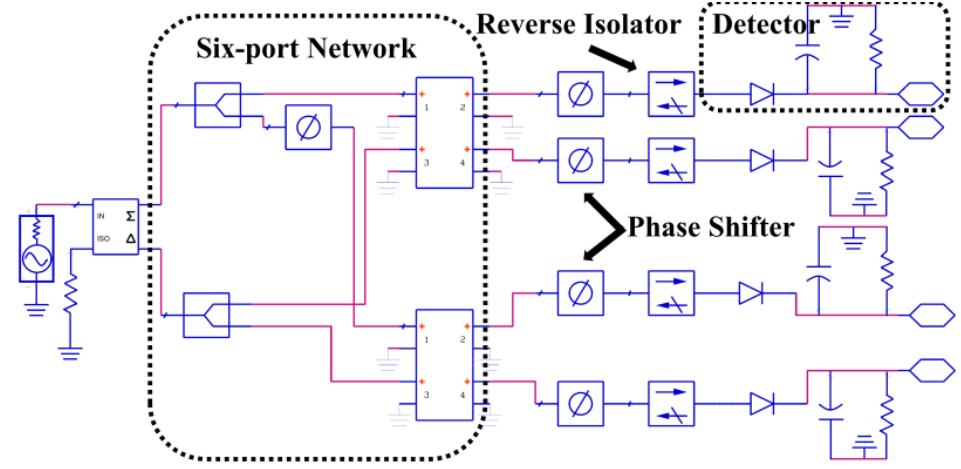
Figure 2. Simulation model of analog correlator in ADS. Firstly, when the isolation and return loss of each port in the six-port network are fixed transmission line of the detector and the six-port network on the correlation results can be